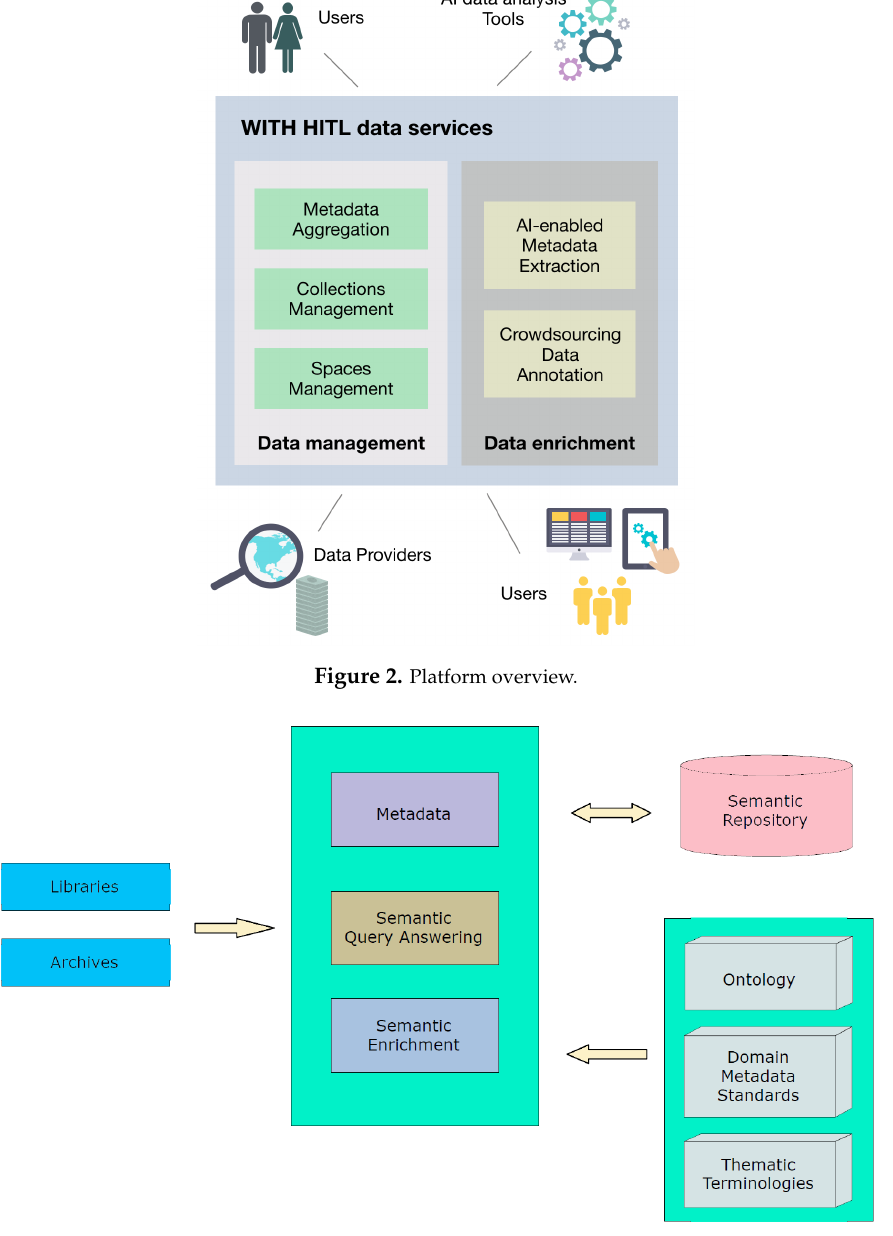
Figure 3. Platform architecture